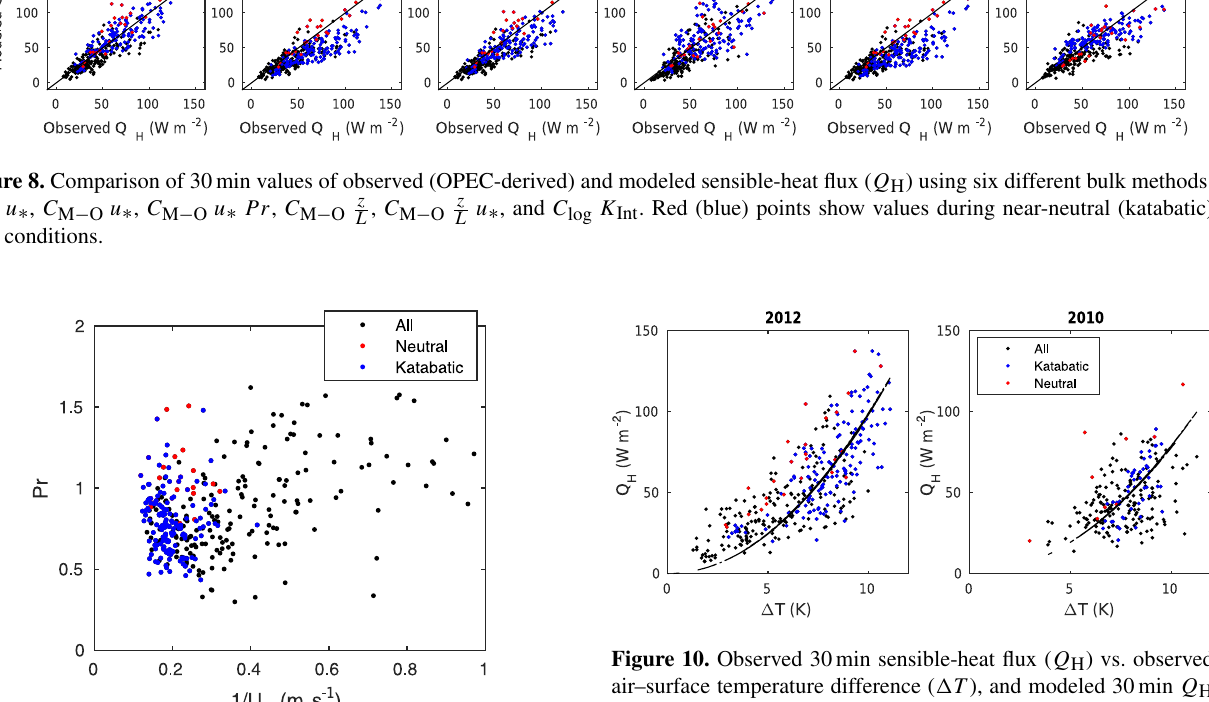
Figure 9. Measured eddy Prandtl number vs. the inverse of the wind speed.